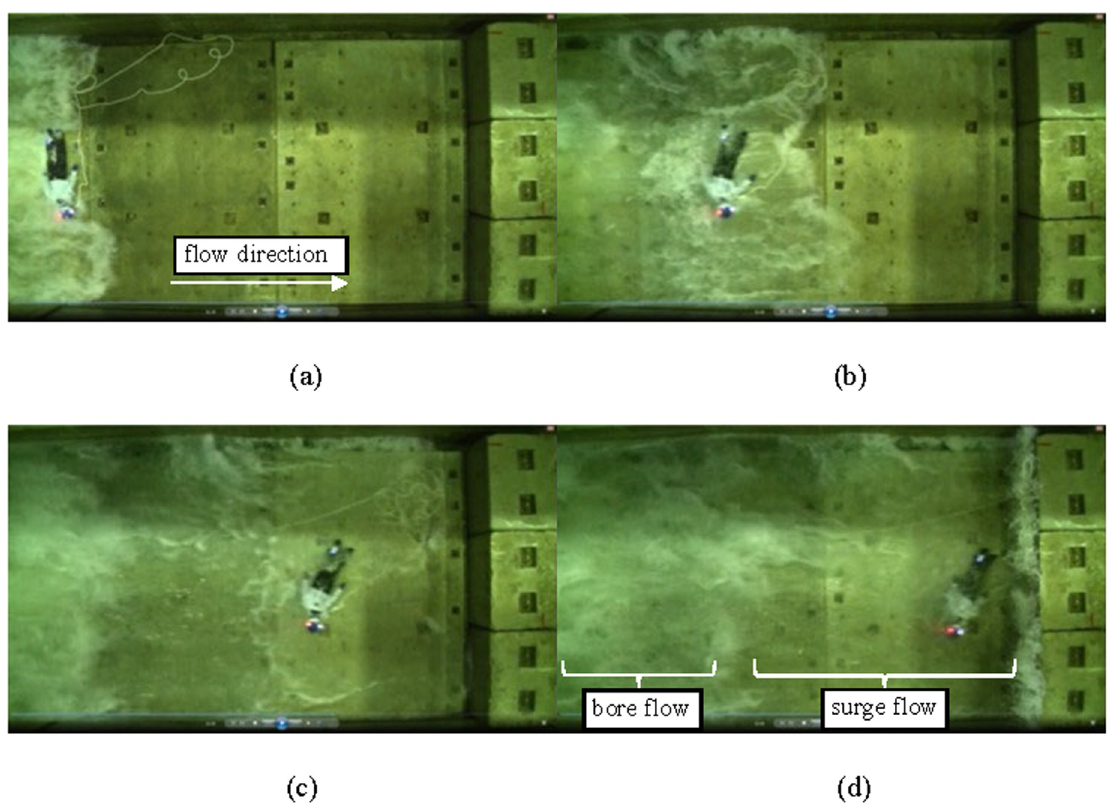
Fig 4. Frame recorded from the top view (KM, without PFD): (a) 0 s (b) ca. 0.4 s (c) ca. 1.5 s (d) ca. 1.8 s.